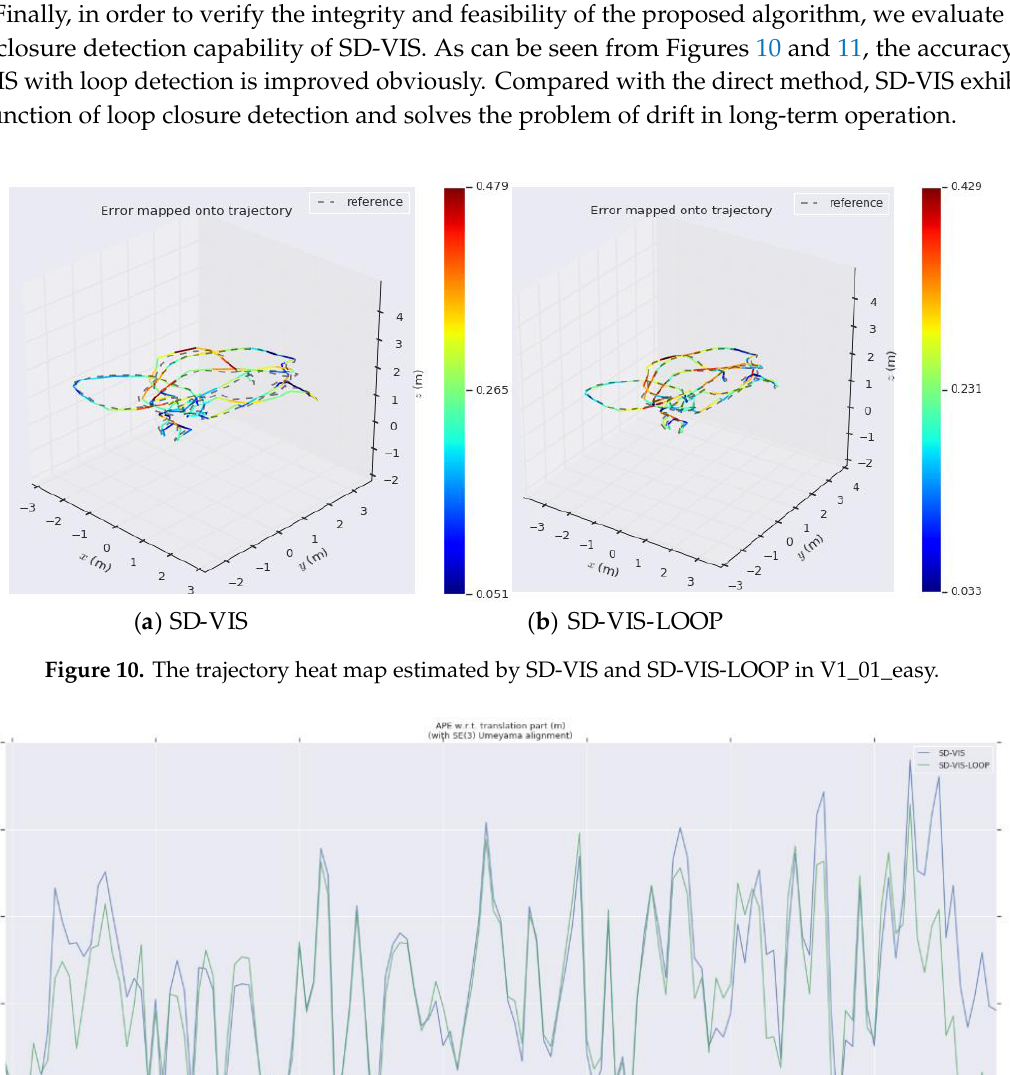
Figure 9. The left picture ( a ) shows a comparison of the number of keyframes and non-keyframes. The right picture ( b ) shows the comparison of time consumption between tracking keyframes and